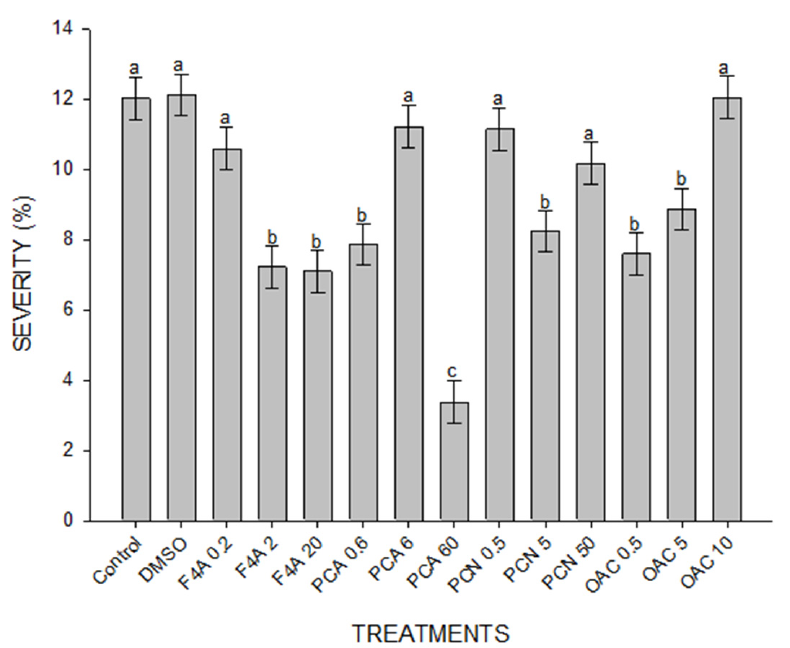
Figure 4. Disease severity caused by P. pachyrhizi in soybean leaves treated with different secondary metabolites produced by P. aeruginosa LV strain, 14 days after inoculation. The fungal spores were inoculated 24 h after treatment. Distilled H 2 O (Control); DMSO + mineral oil (DMSO); semi-purified fraction (F4A); phenazine-carboxylic acid (PCA); phenazine carboxamide (PCN); organocopper compound (OAC). The numbers after compound legend indicate their concentration ( µ g mL − 1 ). Different letters indicate significant differences by Tukey test at p < 0.05. Bars indicate standard deviation. CV = 61.94%.